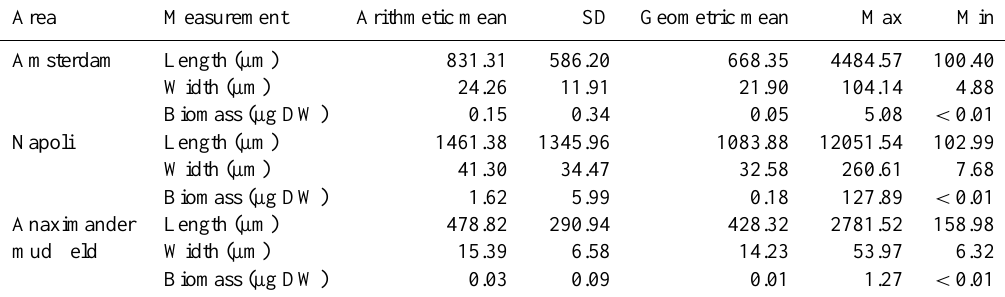
Table 7. Nematode morphometrics and biomass